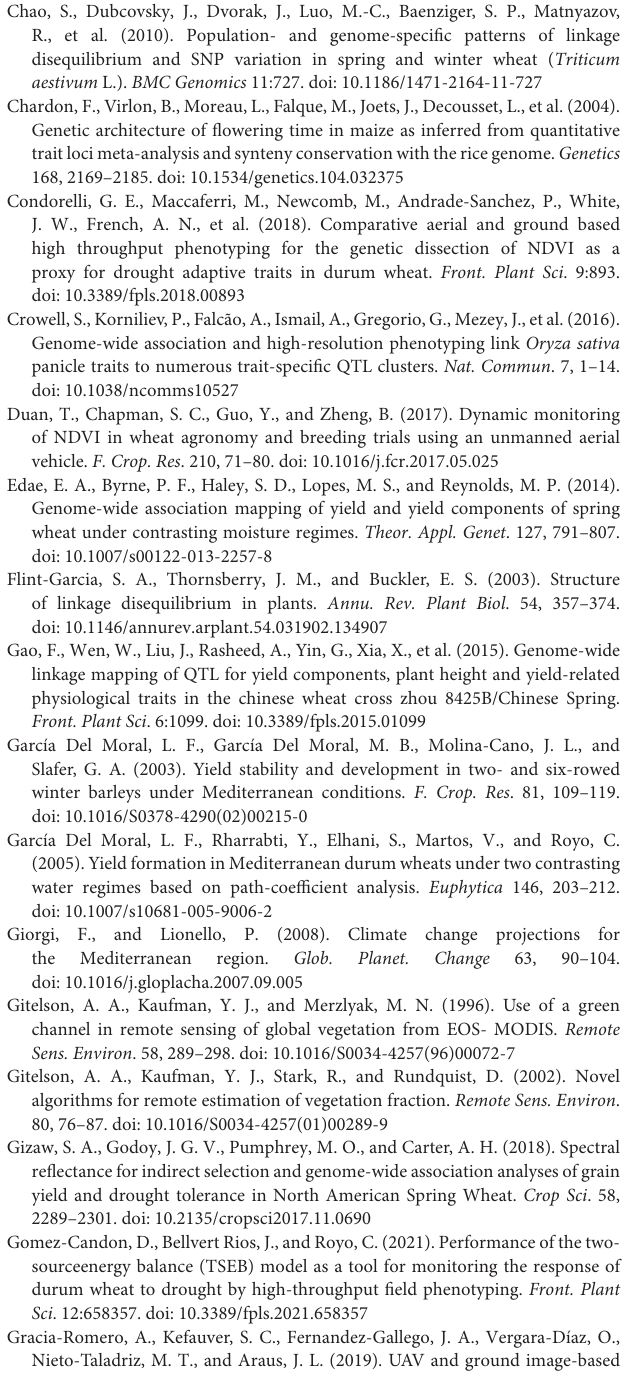
Supplementary Table 5 | Marker trait associations (MTAs). Supplementary Table 6 | QTL hotspots. Supplementary Table 7 | Gene models within QTL